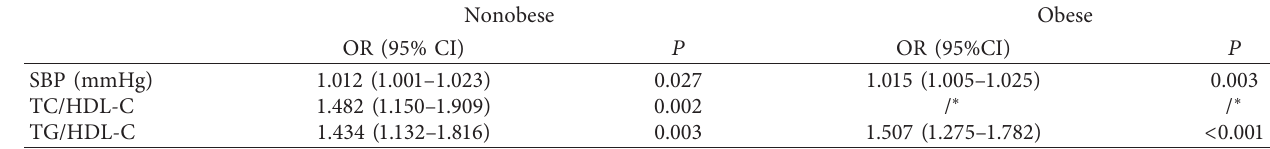
Table 3: Multiple logistic regression analysis: the associations of SBP, lipid ratios, and insulin resistance.